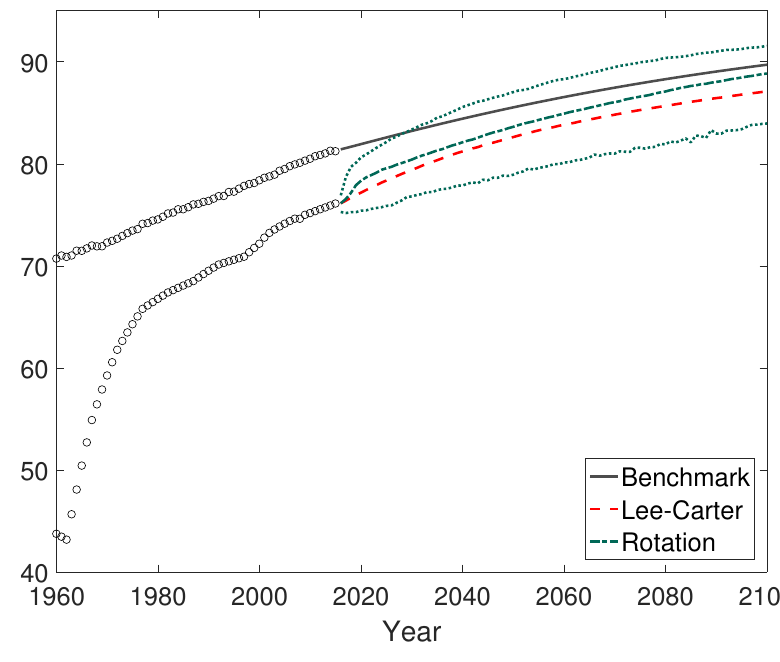
Figure A4. The average projected life expectancy of the benchmark countries and China using the rotation algorithm and the independent Lee–Carter